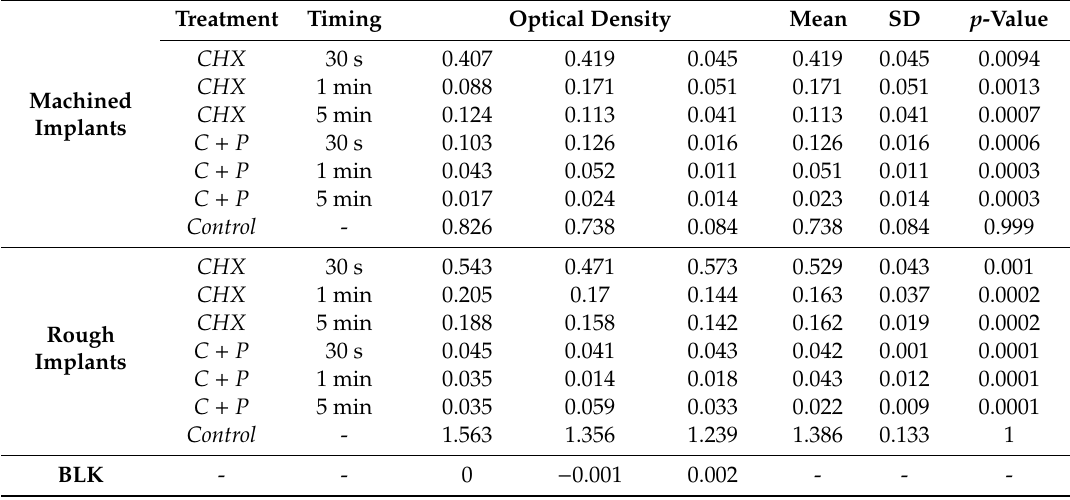
Table 1. Optical density (OD) values of all